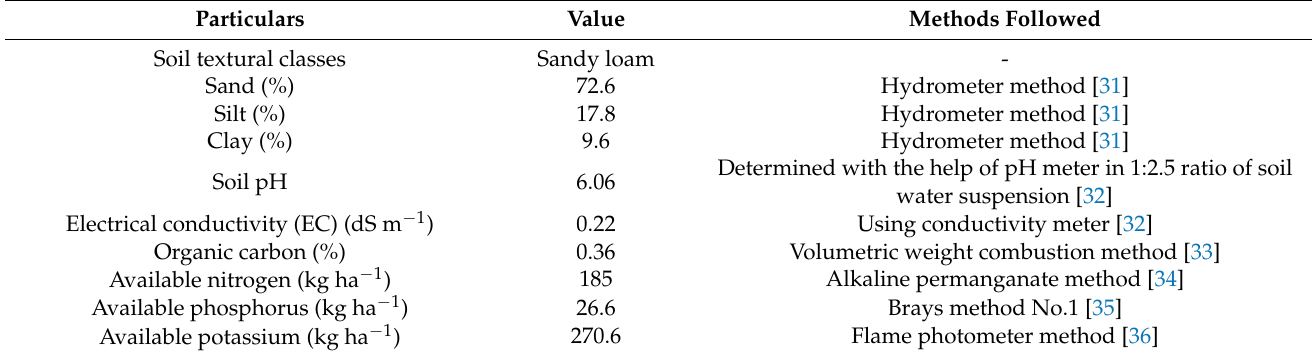
Table 1. Initial soil fertility